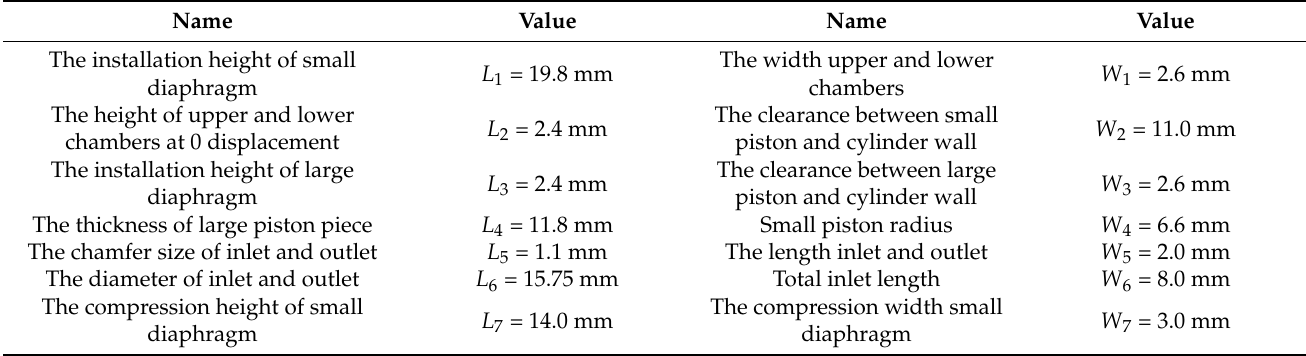
Table 2. The structural parameters of support